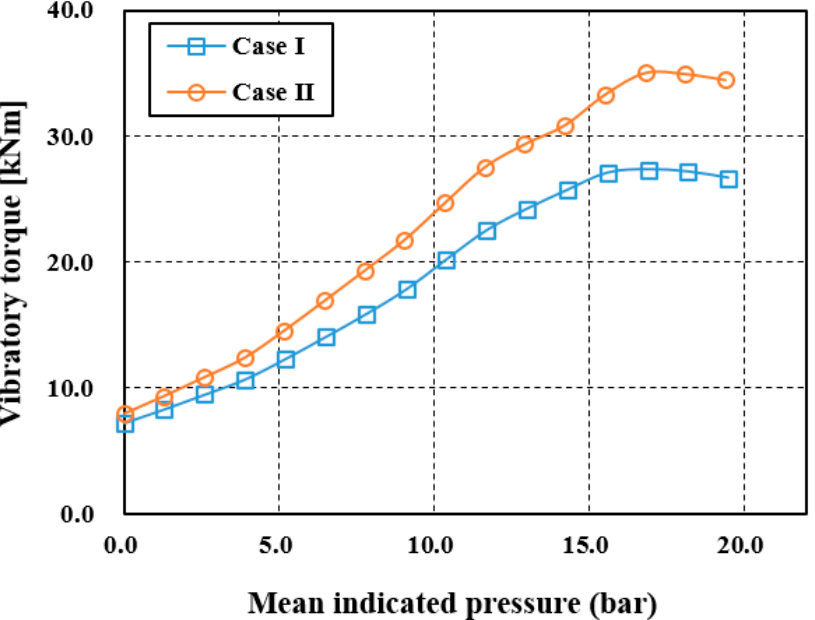
Figure 1. Comparison of sixth-order vibratory torque between two engine models with different stroke values.